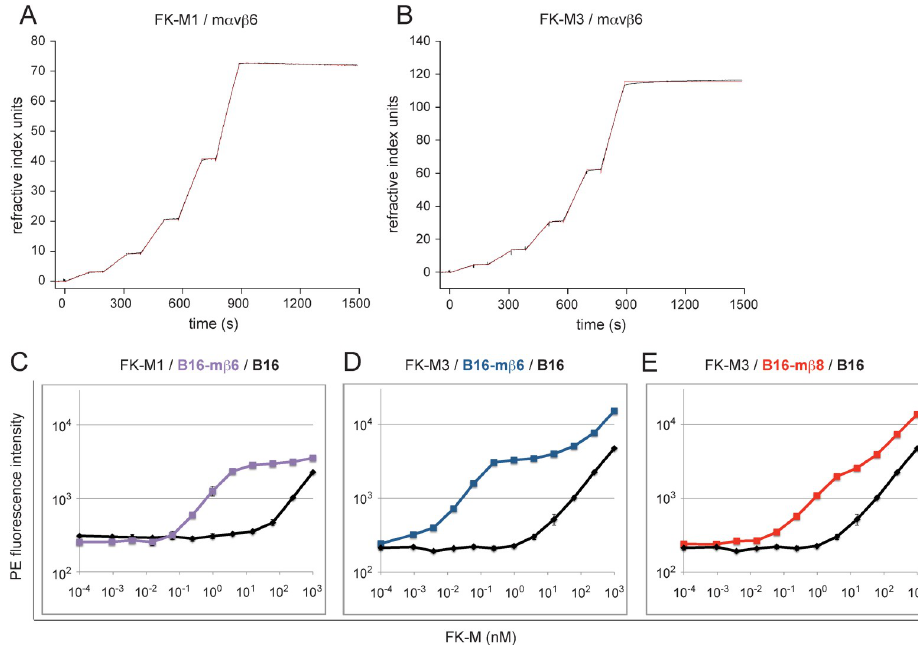
Fig 7. FK affinity determination to sITG α v β 6 and α v β 8 by SPR analysis and to cell surface integrins by saturation binding. (A, B) Sensor chips containing immobilized biotinylated FK-M1 and FK-M3 were probed with mouse sITG α v β 6. Following consecutive analyte injections over 120 s, dissociation was monitored for 600 s (black). Sensorgrams were fitted with a 1:1 kinetic model (red). (C-E) FK saturation cell binding assays using cells with defined α v β 6/ α v β 8expression included FK-M1 binding to B16-m β 6 (C), FK-M3 binding to B16-m β 6 (D) and FK-M3 binding to B16-m β 8 (E). Parental B16 cells were included in order to subtract background levels when calculating equilibrium dissociation constant K D values by Scatchard plot